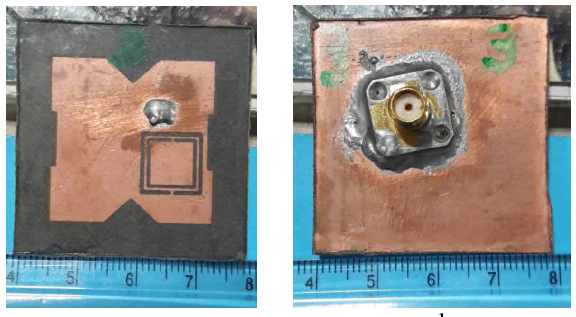
Figure 8: Fabricated prototype a top view b bottom view The measured return loss characteristics along with simulated data are given in Fig. 9. Measured results are in close agreement with simulated results. The discontinuity at upper resonating band indicates the possibility of circular polarization radiation.